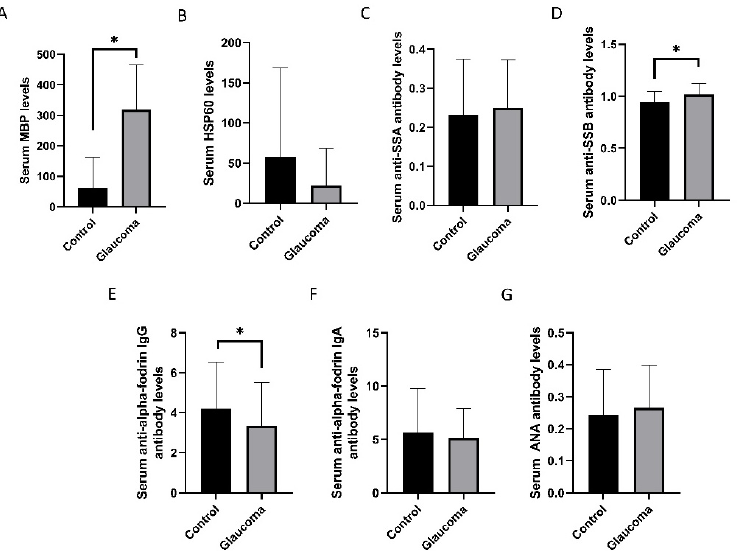
Figure 2. Comparison of serum markers between control and glaucoma patients. Serum myelin basic protein (MBP) levels ( A ) and serum anti-Sjögren’s-syndrome-related antigen B (SSB) antibody levels ( D ) were higher in patients with glaucoma than in the control participants. Serum levels of heat shock protein 60 (HSP60) ( B ) and serum anti-Sjögren’s-syndrome-related antigen A (SSA) antibody ( C ) were not different between the groups. Anti- α -fodrin IgG antibody levels ( E ) were lower in patients with glaucoma than in the control participants. Anti- α -fodrin IgA antibody ( F ), and anti-nucleic acid (ANA) antibody ( G ) levels were not different between the groups. * p < 0.05 by Mann–Whitney U